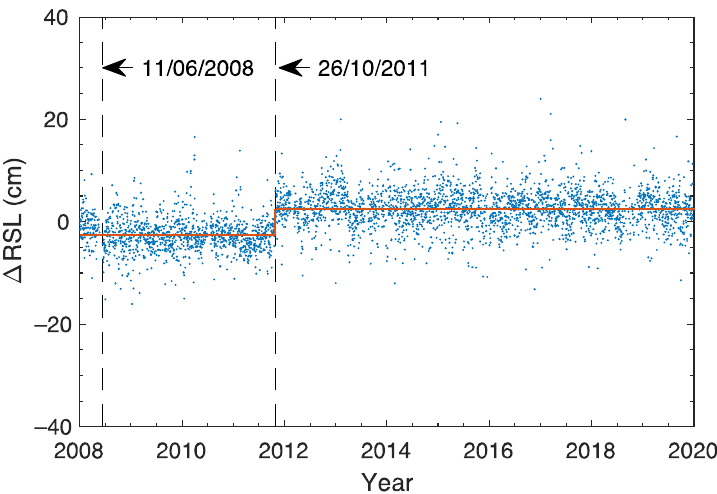
Figure A8. Same as Figure A7, but for BRST.